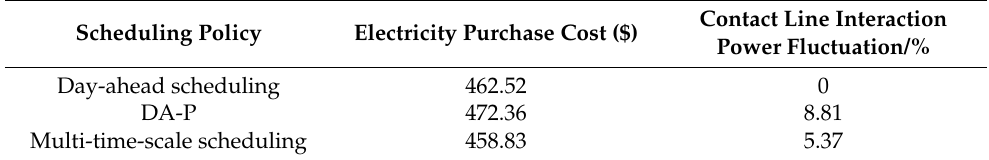
Table 1. Running results of IES under different strategies.